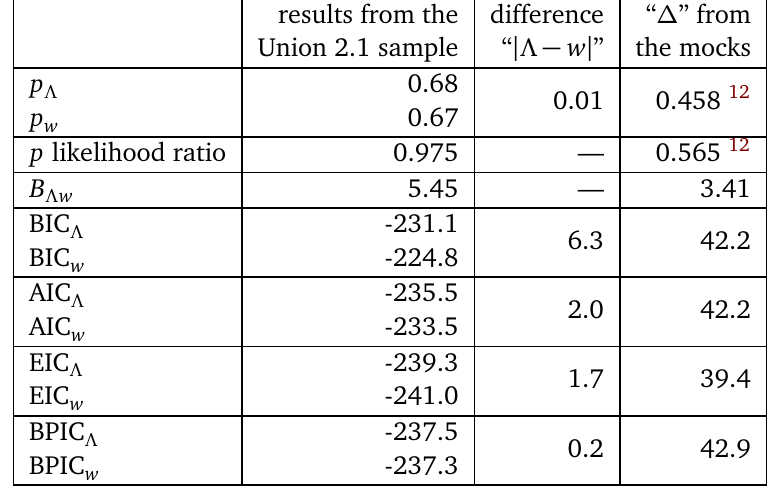
Table 1: A summary of the results from the Union 2.1 data set together with the dispersion estimated from the Λ CDM mock samples as described in the